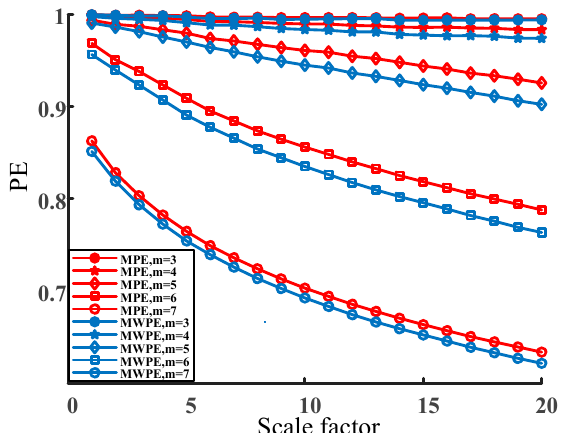
Figure 1. Multi-scale permutation entropy and multi-scale weighted permutation entropy of white noise with different scale factors and embedding dimensions. Under the above parameter conditions, a pulse signal is added to the Gaussian white noise to obtain the signal shown in Figure 2, where the sampling frequency is 1000 Hz, and the pulse signal is added at 0.5 s to collect a total of 1000 points. Figure 2. Adding pulses to white noise. The collected 1000 points were grouped into 200 points in each group. The third group contains the impulse signal, and the entropy values are calculated using multi − scale permutation entropy and multi − scale weighted permutation entropy, respectively. The results are shown in Figure 3.